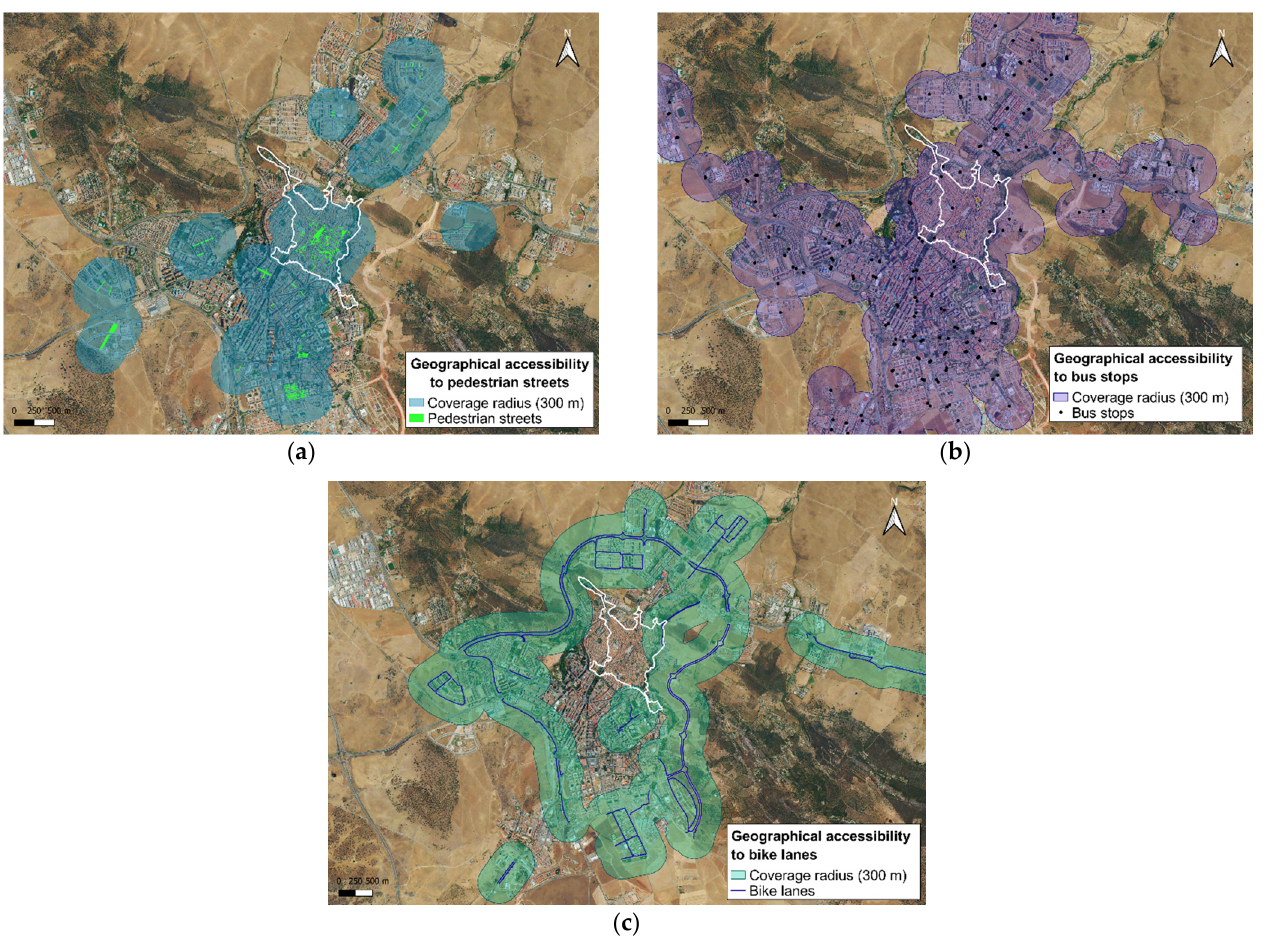
Figure 3. Maps of Accessibility to urban indicators towards non-car-based mobility systems: ( a ) pedestrian streets; ( b ) bus stops; ( c ) bike lanes.